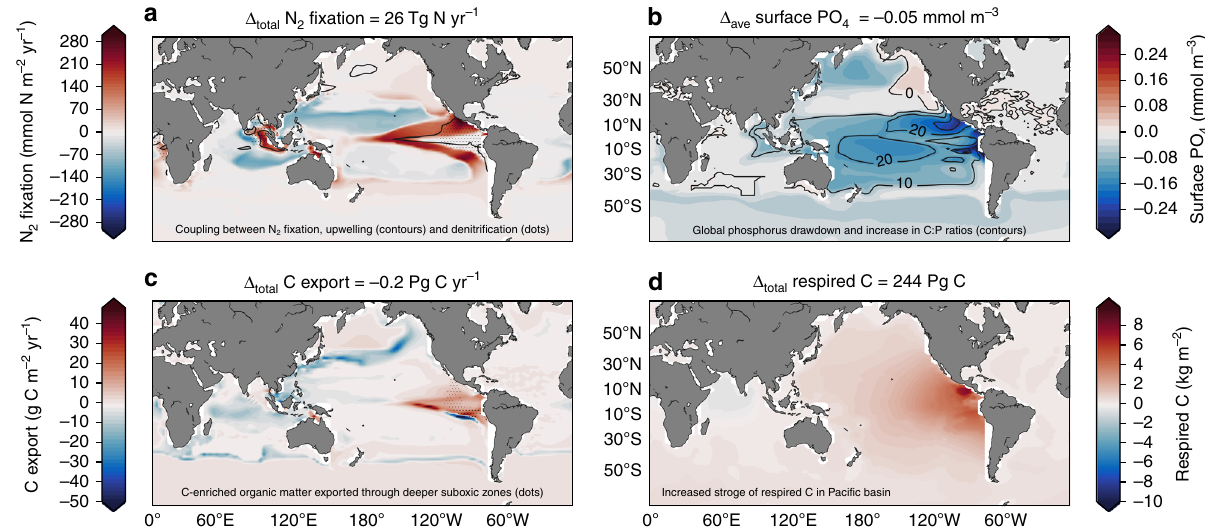
Fig. 1 Biogeochemical response to an Fe-induced stimulation of N 2 fi xers. Change in a N 2 fi xation rate, b surface PO 4 concentration, c carbon export rate and d total respired carbon through the water column. The changes shown in both the coloured shading and the headings above each panel show the effect of increasing Fe deposition from the modern fl ux to the glacial fl ux 5 . The headings describe the integrated change ( Δ total ) or the average change ( Δ ave ) of each property, calculated as the volume or area weighted sum/average of each property. Dots in ( a ) represent active water column denitri fi cation. Contours in ( a ) de fi ne upwelling where ideal water age >25 years at 80 metres depth. Contours in ( b ) are the change in C:P ratios of exported organic matter. Dots (dashes) in ( c ) de fi ne a vertical expansion (shrinking) of suboxia >500